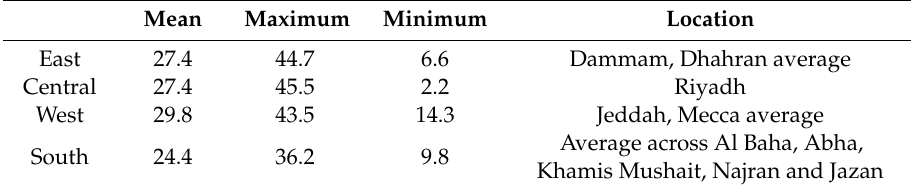
Table 1. Temperature characteristics of the most populated areas in each region for 2015 ( ◦ C).